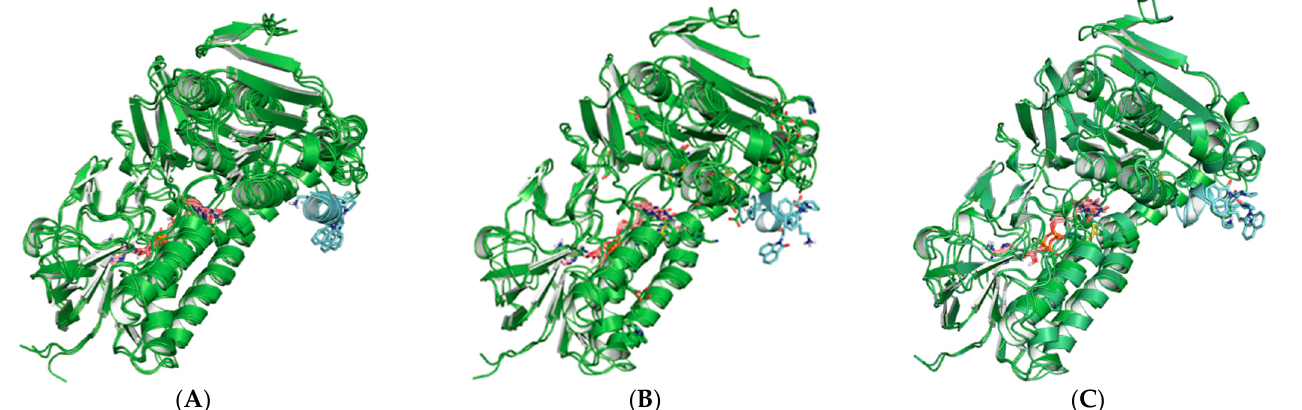
Figure 3. Time evolution of the simulated complex between Li TryR monomer (C atoms in green) and SMPC 4d (C atoms in cyan). The superimposed snapshots correspond to times 5, 25, and 50 ns ( A ), 75 and 100 ns ( B ), and 125 and 150 ns ( C ) of the unrestrained molecular dynamics trajectory in explicit solvent. The FAD cofactor is displayed as sticks with C atoms colored in pink.